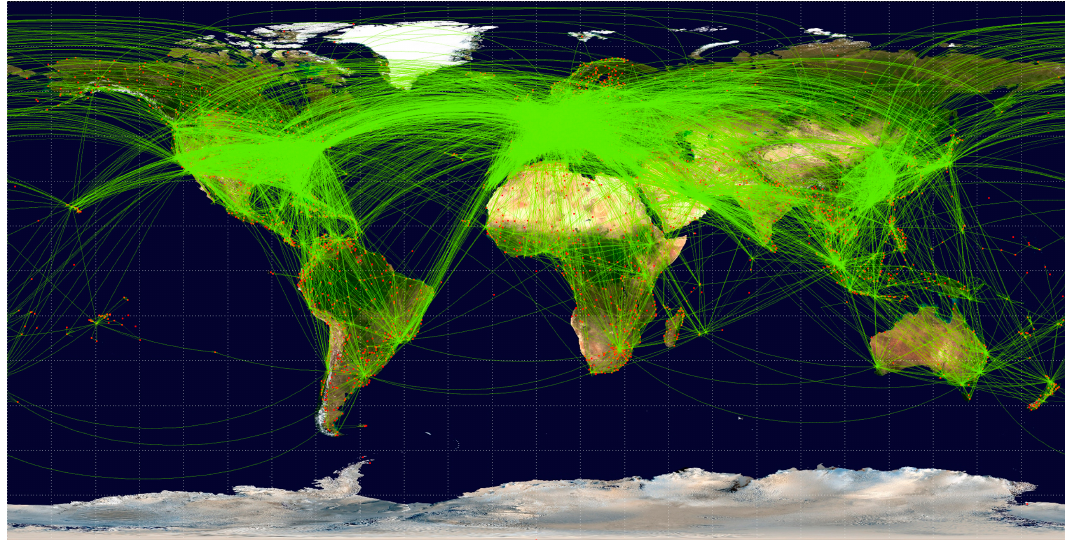
Figure 2. The global ‘aeromobile’ network of the present day, from http://openflights.org. Note the extreme node density in Europe.